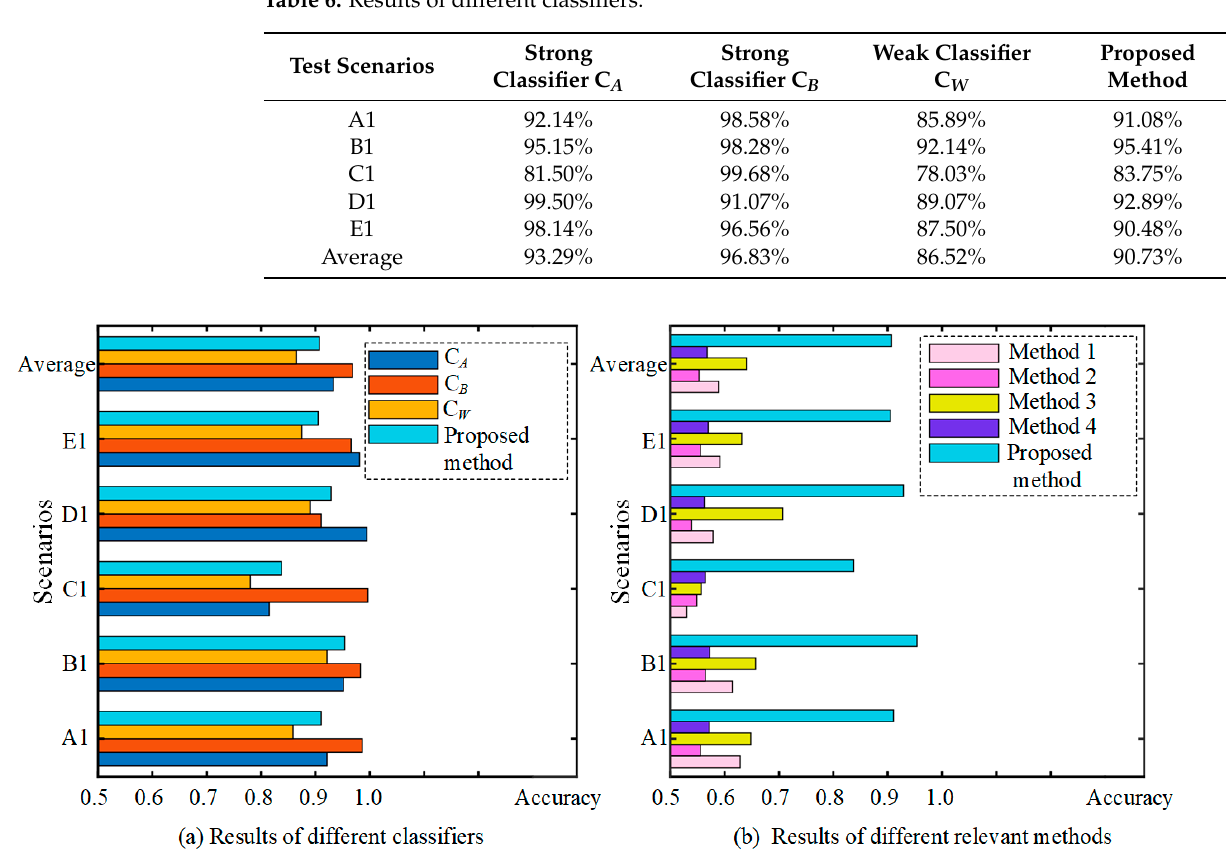
Figure 10. The result diagram for different classifiers. Table 7. Results of different methods.